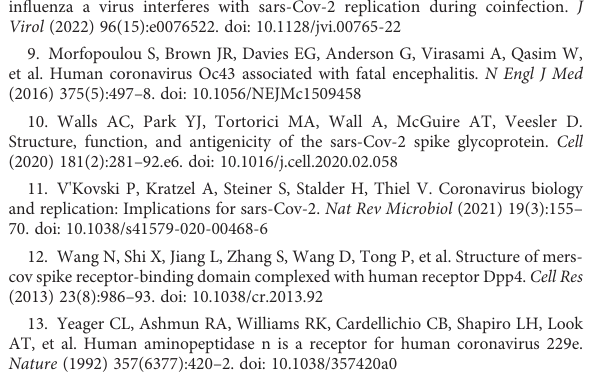
SUPPLEMENTARY FIGURE 3 Amino acid sequence alignment of the stem region of spike proteins of sevenhCoVs.Thealignmentwasperformedusingspikeproteinsequences: MERS-CoV (GenBank accession number: AFS88936.1), SARS-CoV-2 (NCBI Reference Sequence: YP_009724390.1), SARS-CoV (NCBI Reference Sequence: NP_828851.1), OC43 (GenBank: AVR40344.1), HKU1 (UniProtKB/Swiss-Prot: Q0ZME7.1), NL63 (GenBank: APF29071.1), and 229E (GenBank: APT69883.1). Sequence alignment was performed